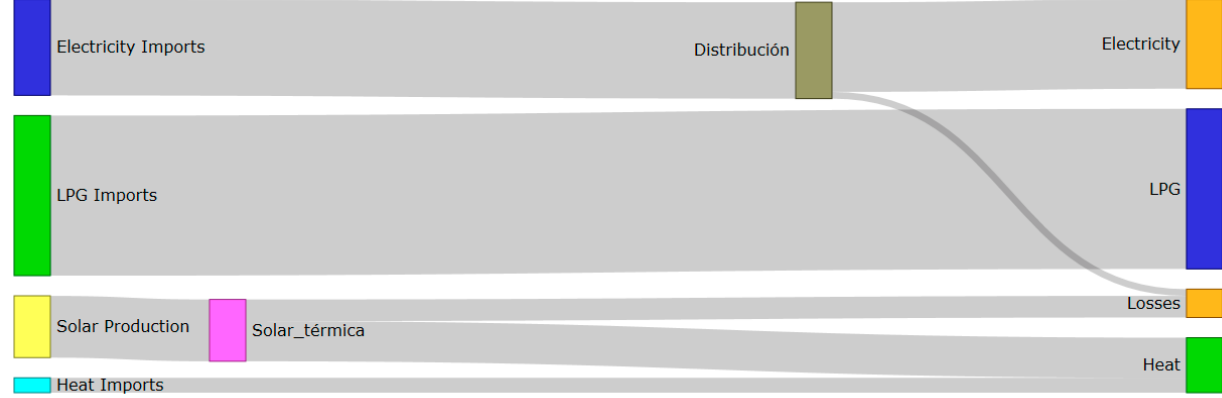
Table 15. Energy balance intensive insertion of ST